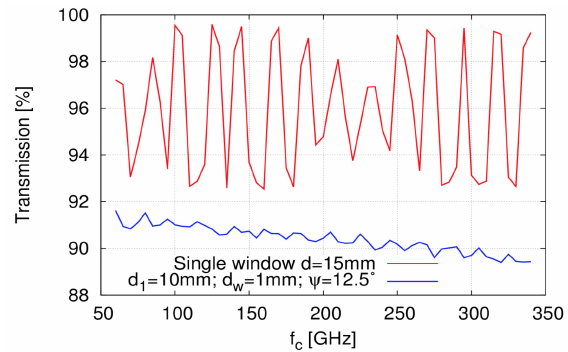
Figure 2. Comparison of the transmission for a single flat win- dow and a double wedge window.